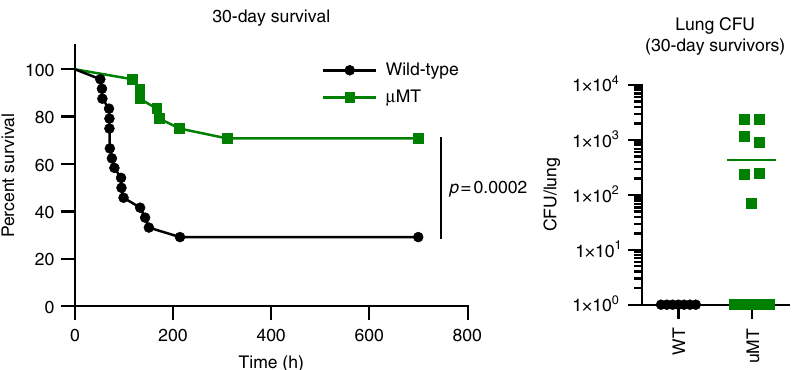
Fig. 6 B cells could drive increased pathology in response to S. pneumoniae infection, independent of bacterial clearance. Ighm tm1 ( µ MT) mice show delayed disease progression and improved overall survival up to 30 days post S. pneumoniae infection, however 41% (7/17) surviving Ighm tm1 mice failed to clear bacteria from the lung tissue at 30 days post-infection compared to 100% clearance in surviving wild-type mice. (Data from 1 study, n = 24, mean CFU count shown, data-points represent individual